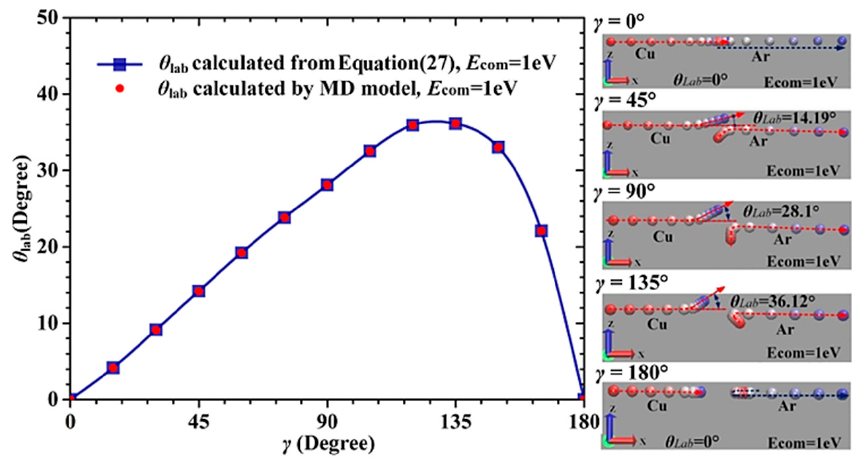
Figure 6. Influence of the initial velocity direction of the Ar atom on the scattering angle of the Cu atom ( E com = 1 eV).